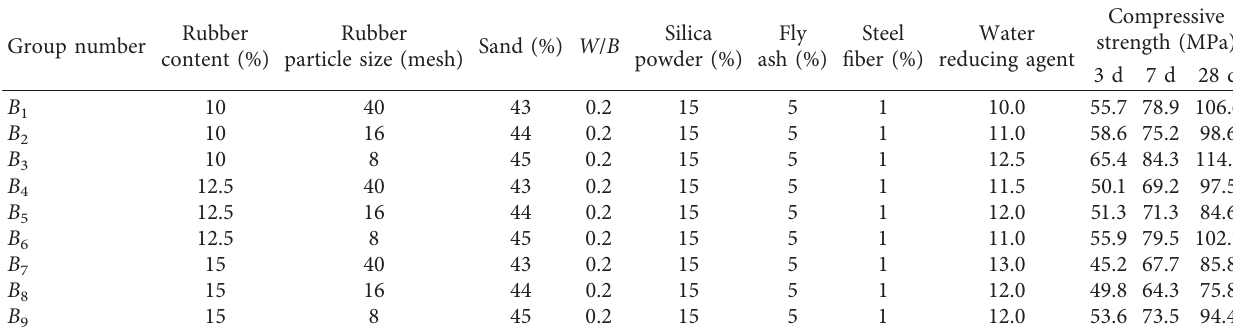
Table 7: Compressive strength test results of rubber UHPC orthogonal test